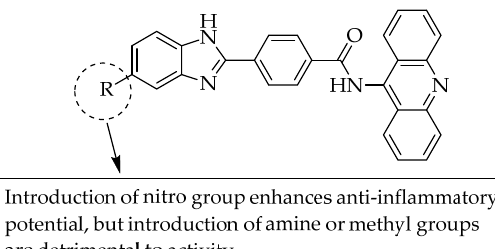
Figure 12. SARs of benzimidazole-acridine derivatives.